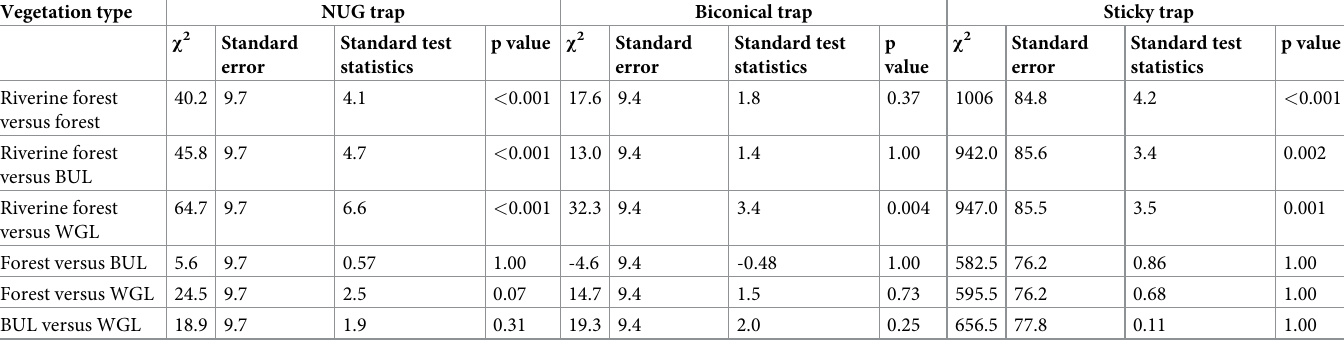
Table 4. Comparison of efficacy of different traps in catching G . pallidipes in different vegetation types, southwest Ethiopia. Vegetation type NUG